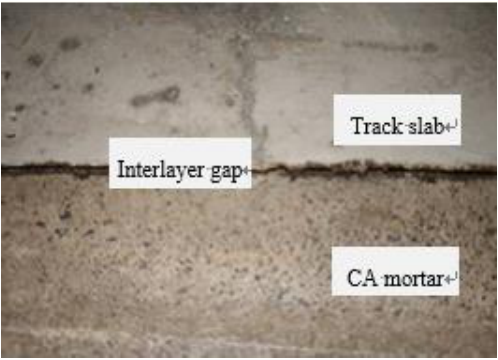
Figure 9. Track slab-CA mortar interlayer gap.